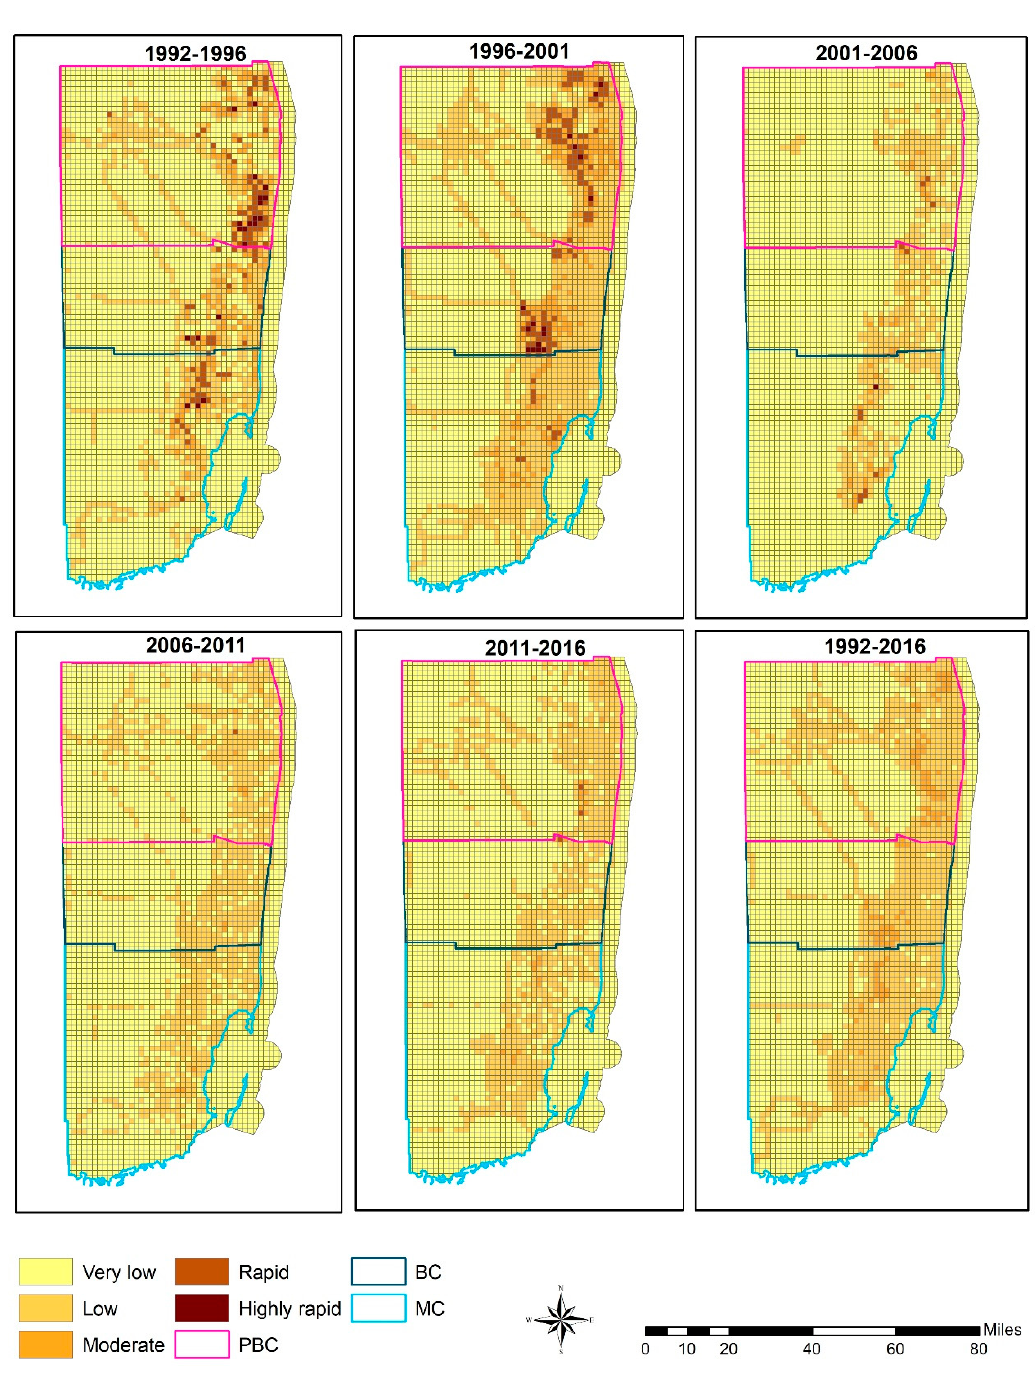
Figure 5. Spatial distribution of UII at MSA and County level at 2 km × 2 km spatial unit.